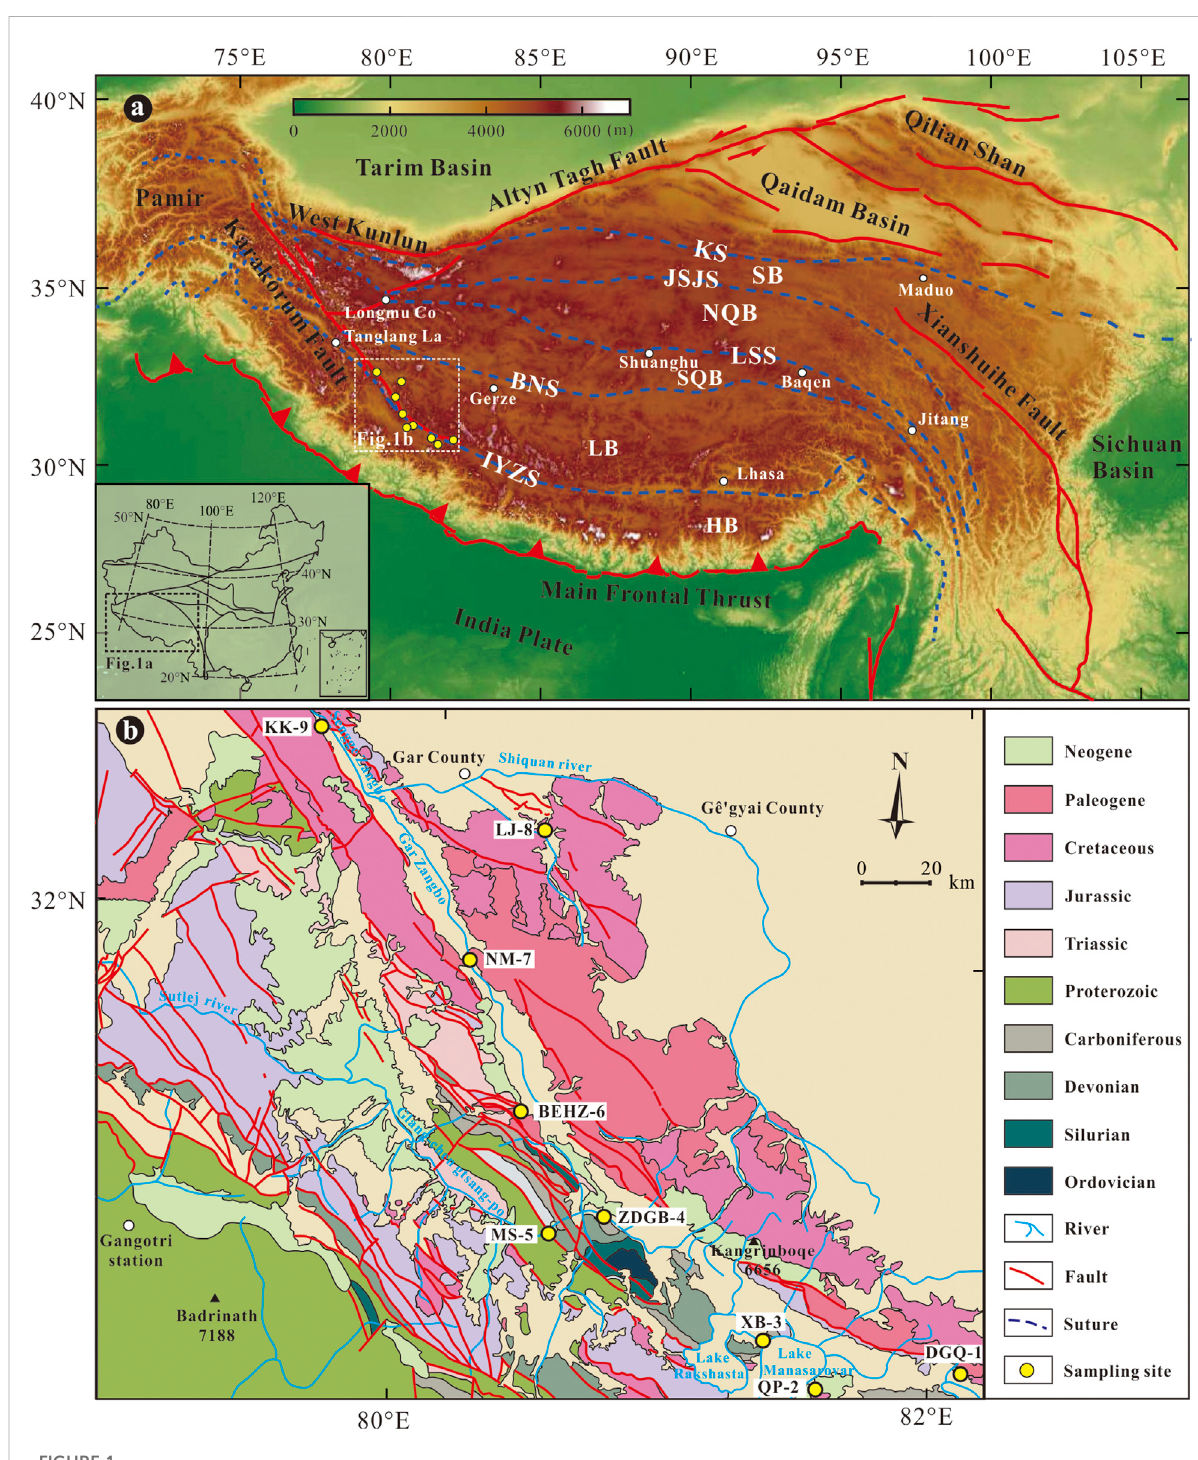
FIGURE 1 (A) TectonicframeworkoftheTibetandsurroundingregions(modi fi edafterLuetal.,2022); (B)